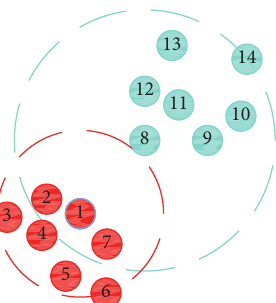
Figure 3: A schematic diagram with parts of samples and its r equals 6. Sample 1 has six NNEs, including samples 2, 3, 4, 5, 6, and 7; sample 8 has six NNEs, including samples 9, 10, 11, 12, 13, and